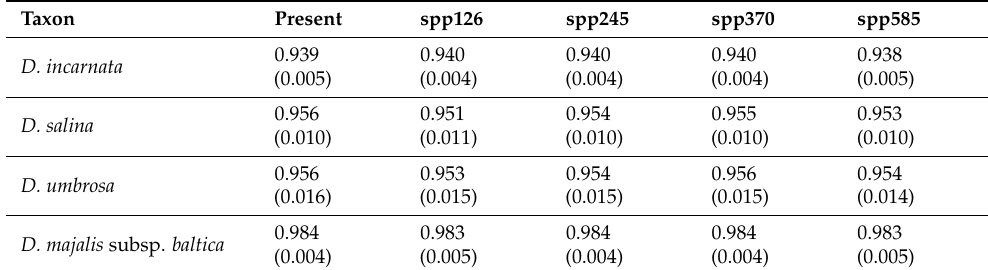
Table 2. The average training AUC for the replicate runs and the standard deviation (in bracket) obtained for models for studied taxa.